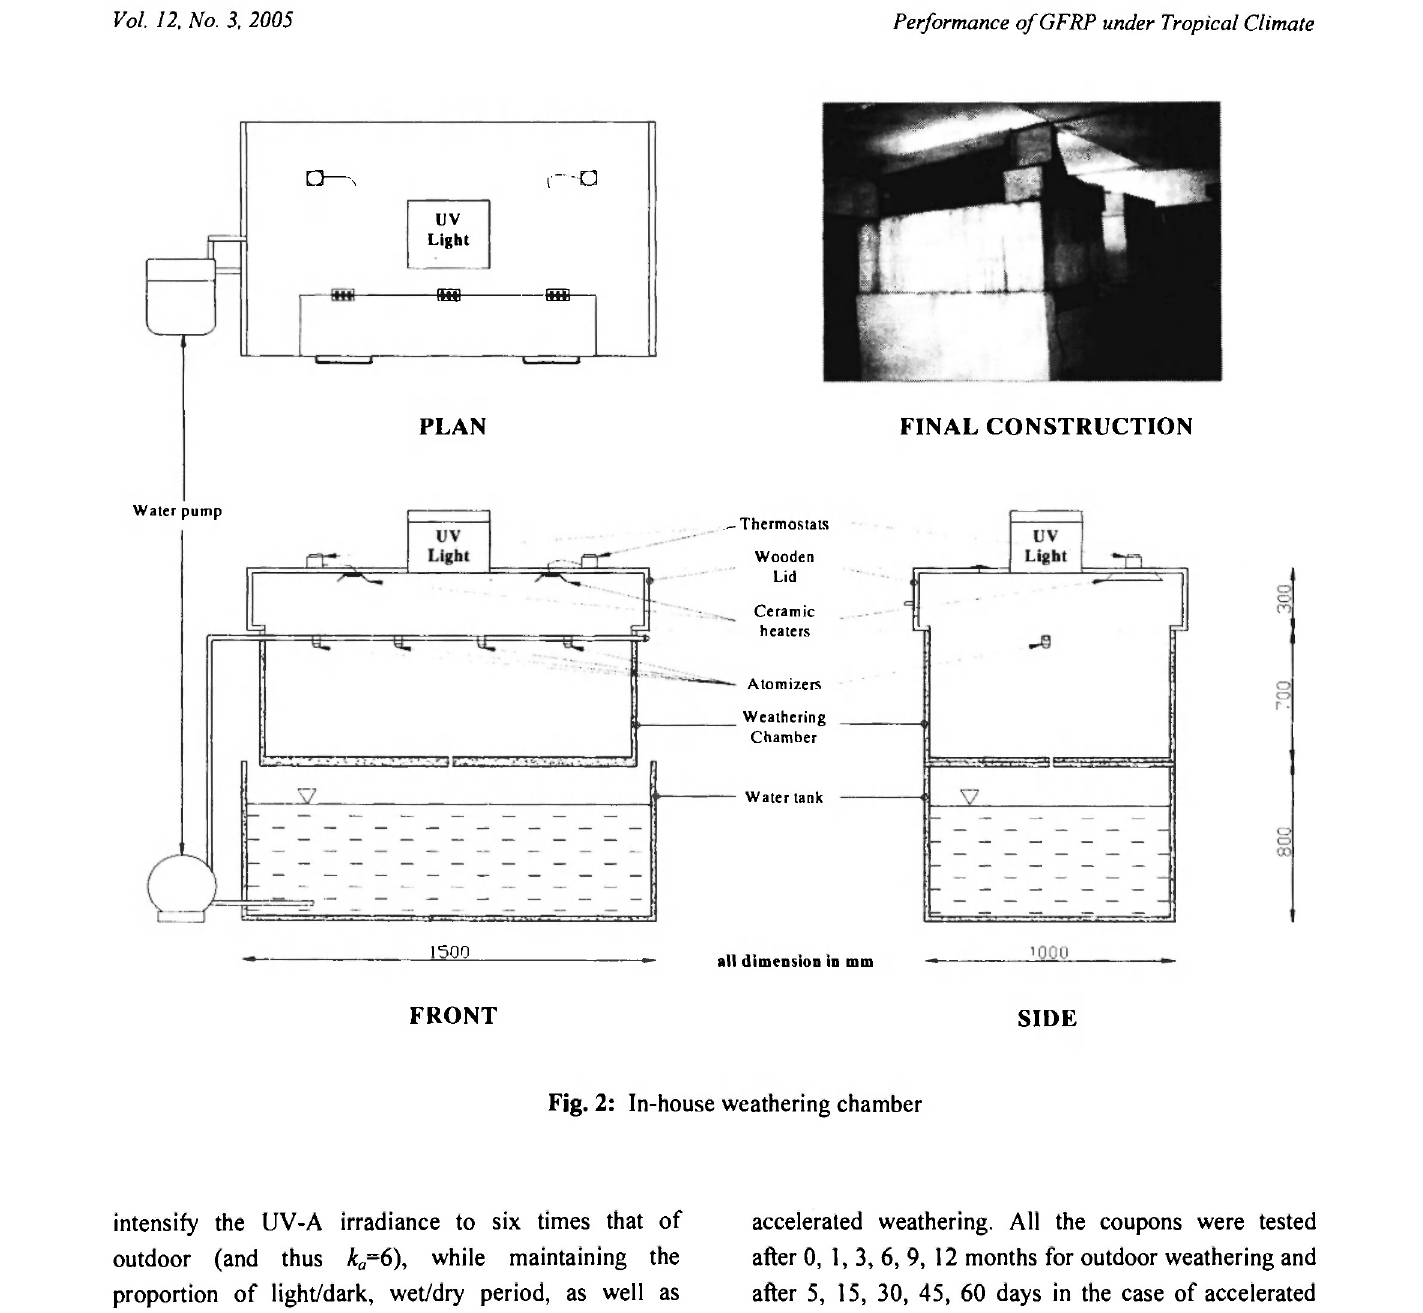
Fig. 2: In-house weathering